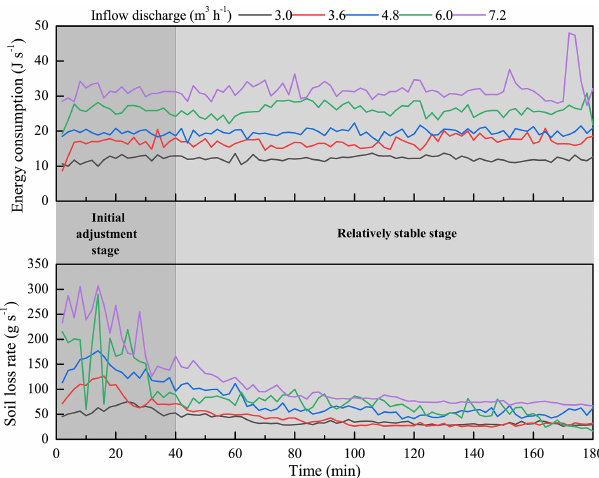
Figure 13. Synchronous change in soil loss rate of the upstream area–gully head–gully bed system and total energy dissipation dur- ing headcut